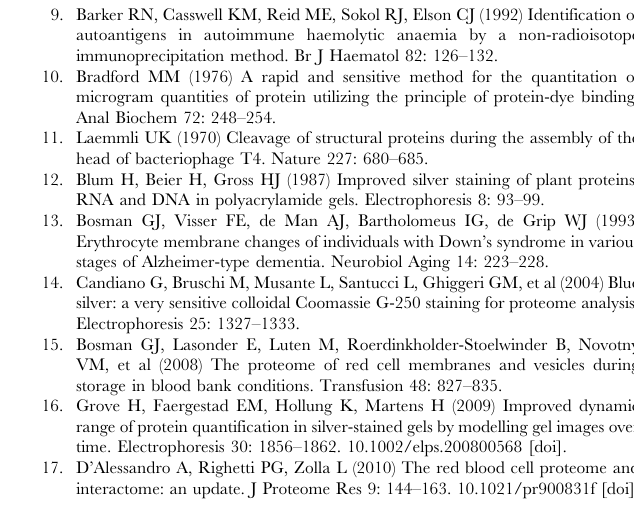
Table S1 Proteins identified by proteomics analyses of erythrocyte/vesicle immunoprecipitations using eryth- rocyte autoantibody-containing plasma of patients 1, 8 and 9, and allogeneic plasma (control). Numbers represent the identified peptide sequences per protein. Either total products or gel slices containing proteins of a certain MW (kDa) were analyzed. Proteins in specific gel slices were also identified (slices I and II: Figure 2B, slice III: Figure 3B). Skin and trypsin contaminants were excluded from this overview. Immunoprecip- itations and proteomics analyses were performed as mentioned in Materials and